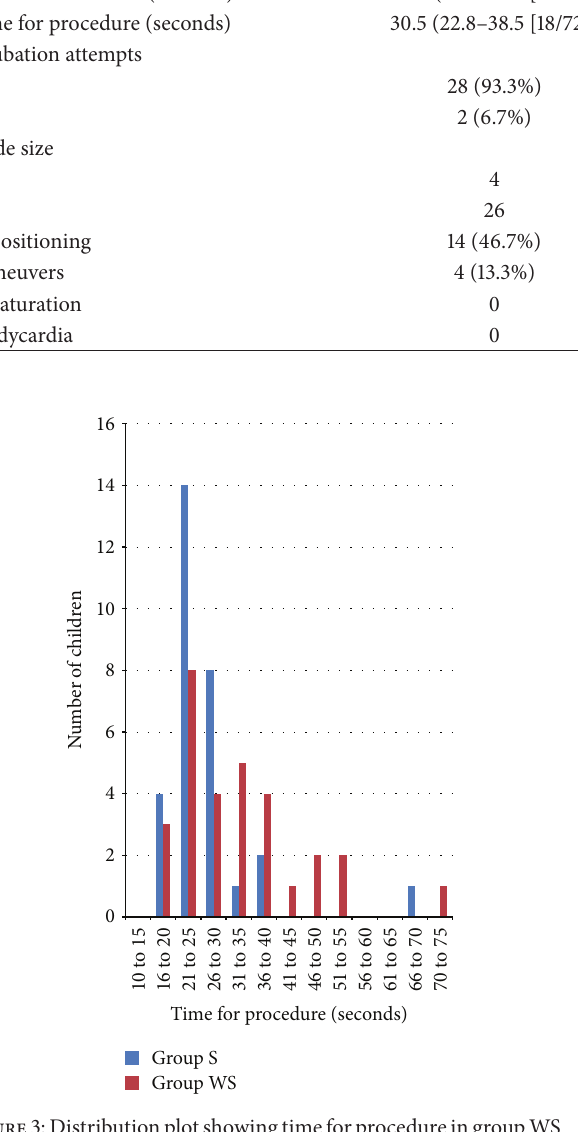
Figure3:DistributionplotshowingtimeforprocedureingroupWS and group